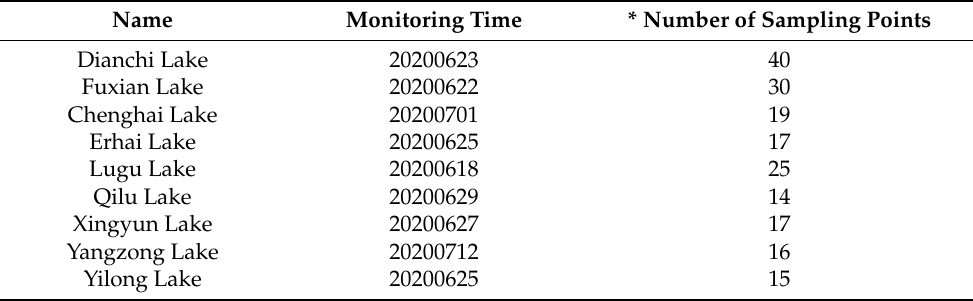
Table 3. Sampling time and the number of chlorophyll-a sampling